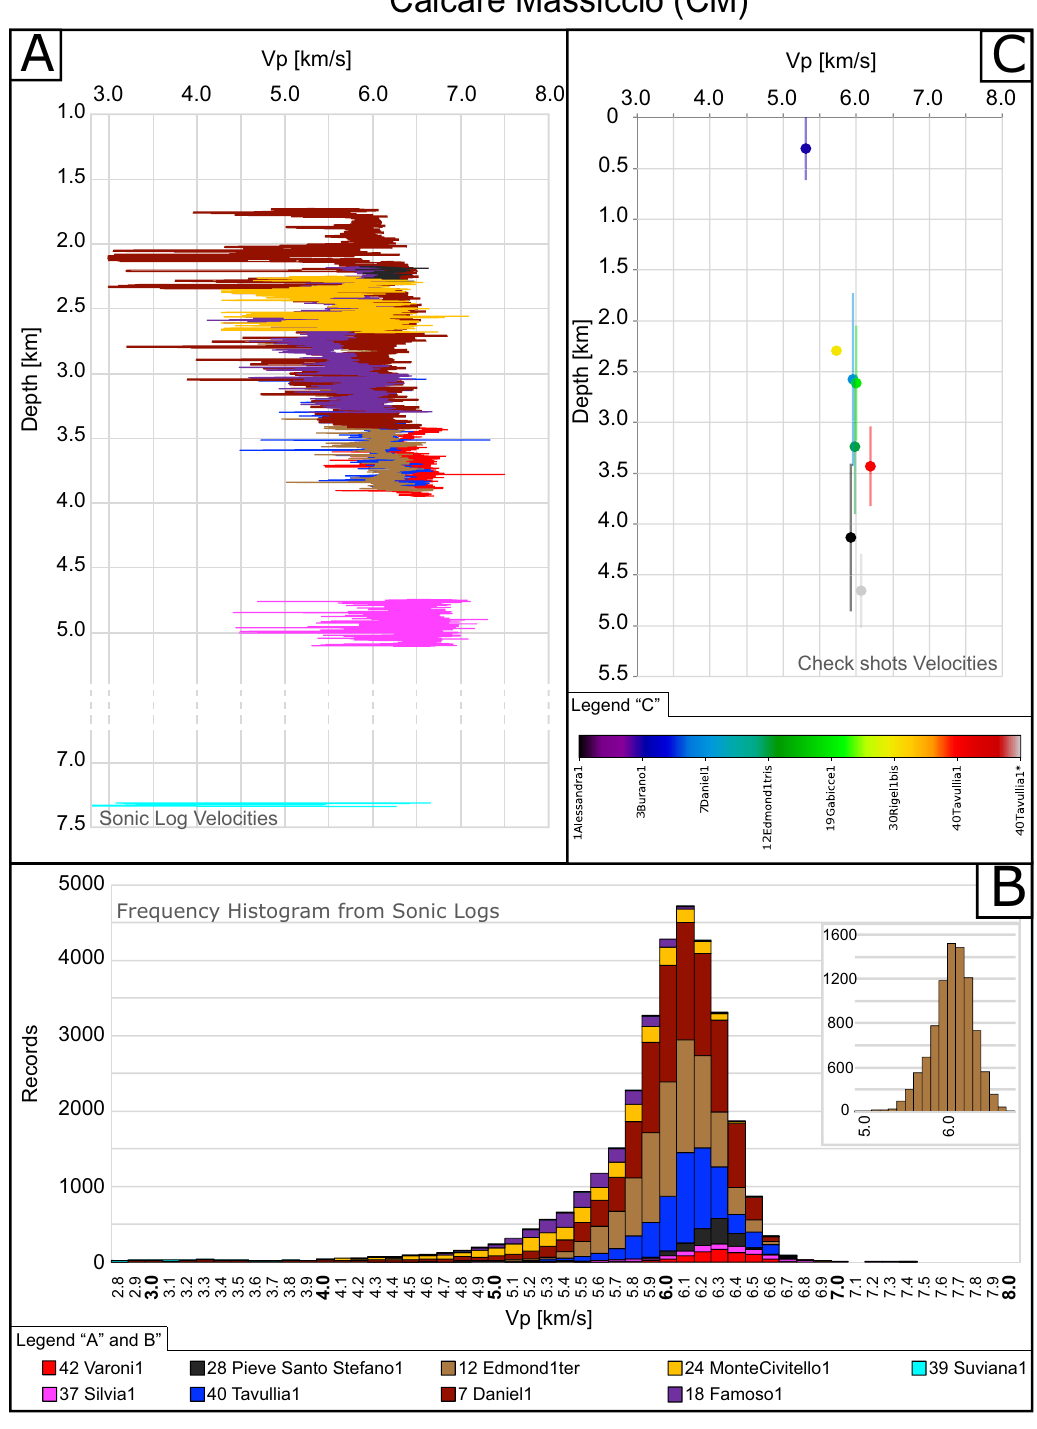
Figure 3. ( A ) In situ Vp sonic logs (SLV) depth profiles of boreholes through Calcare Massiccio (CM). ( B ) Velocity frequency cumulative histograms of the boreholes in panel A; y-Axis shows the number of times (frequency) that a certain velocity was recorded. *Tavullia 1 drilled the CM twice: from 3044 to 3.830 m and from 4298 to 5025 m. Inset shows the frequency analysis of a representative single well (Edmond1tris). ( C ) Interval velocities (IV) depth profile for available boreholes for the CM portions where vertical bars indicate the drilled thickness. Note that IV instrumental error is in the order of 2% (based on estimates in previous literature) 47 and that error bars are reported in Fig.